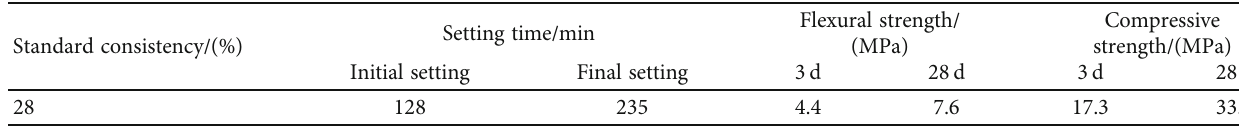
Table 2: Technical indicators of the cement.